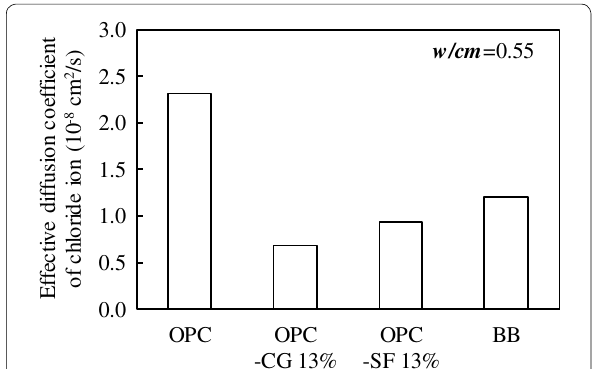
Fig. 4 Effective chloride diffusion coefficient of each concrete composition.